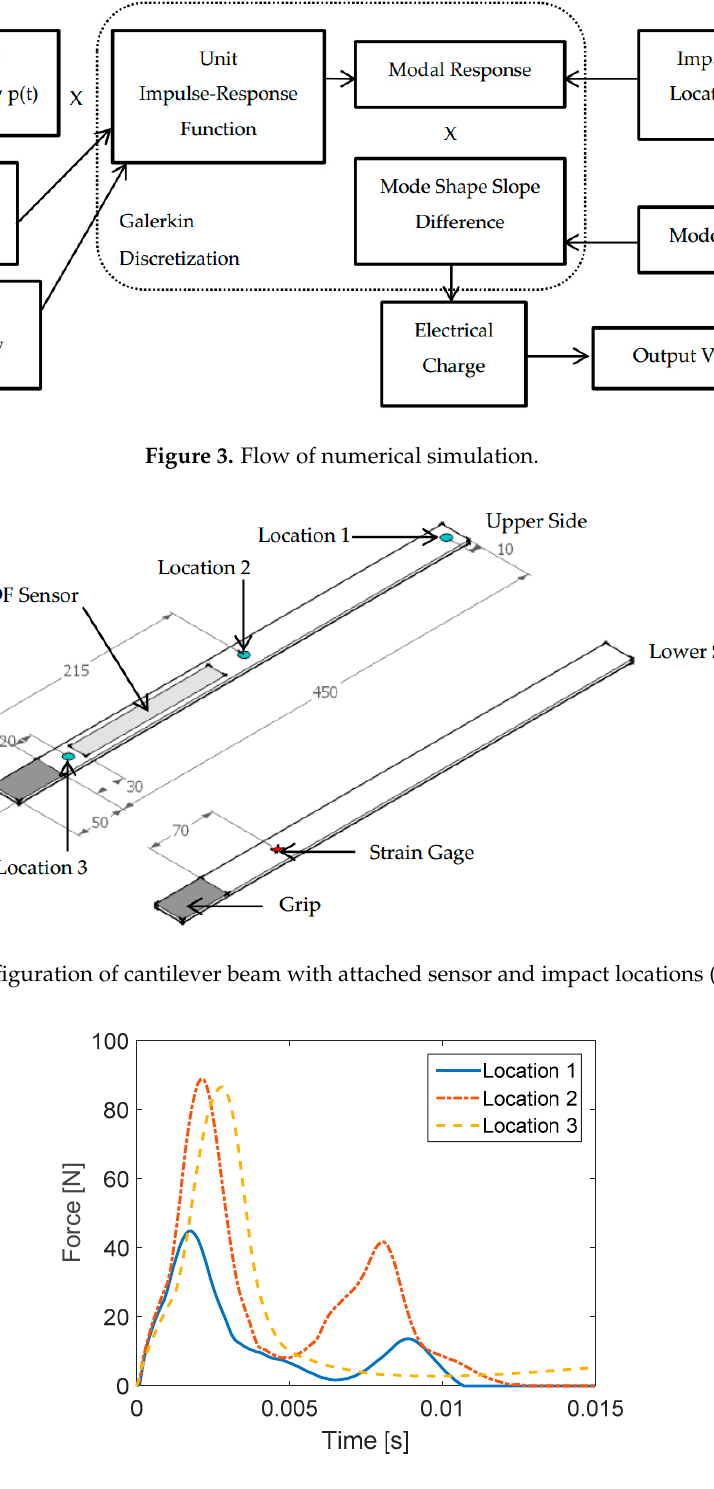
Figure 5. Time-histories of impact loadings at three locations.